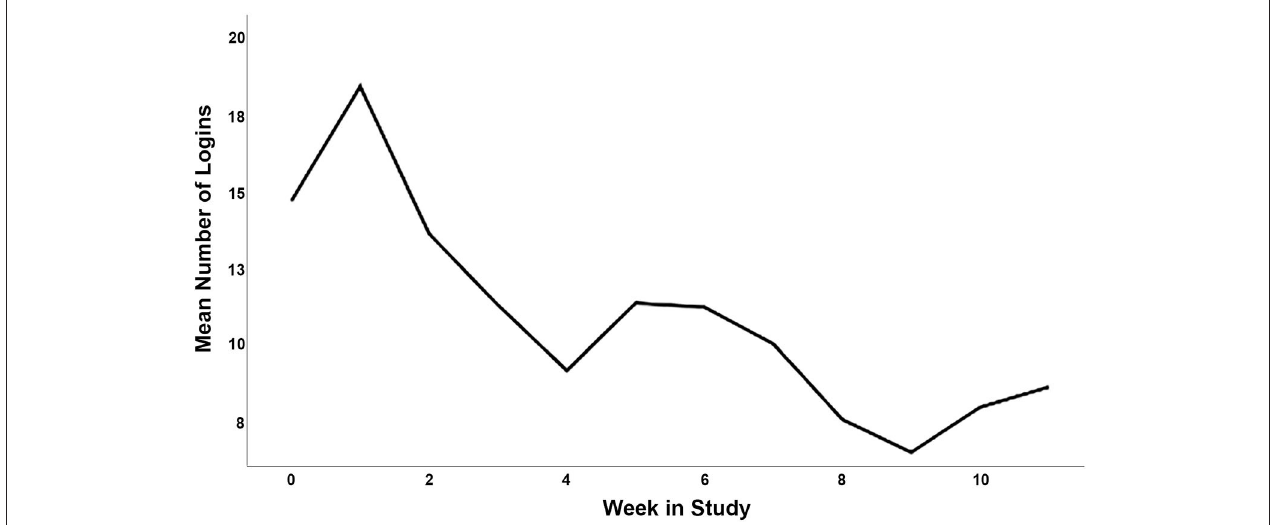
FIGURE 3 | Average weekly app uses (opening app from home screen) in the intervention condition over the 12-week study.